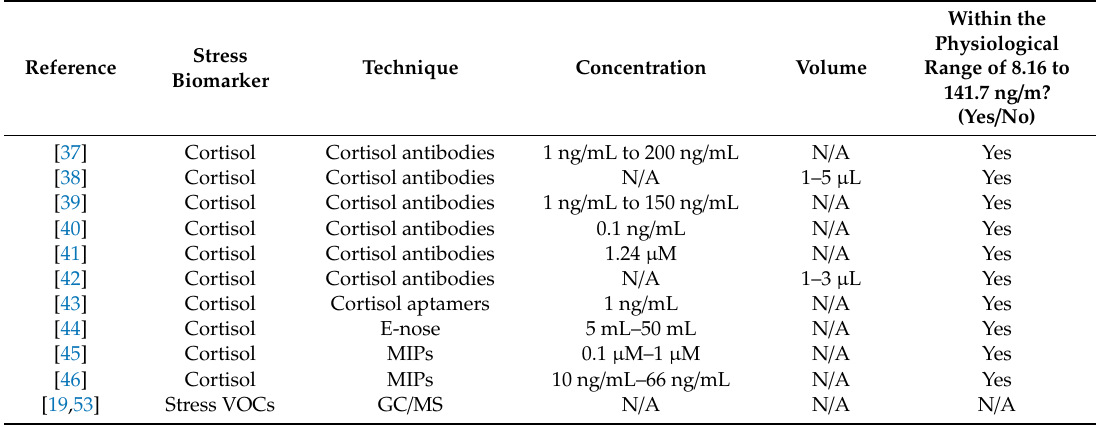
Table 4. Analytical performance summary of the major biosensors